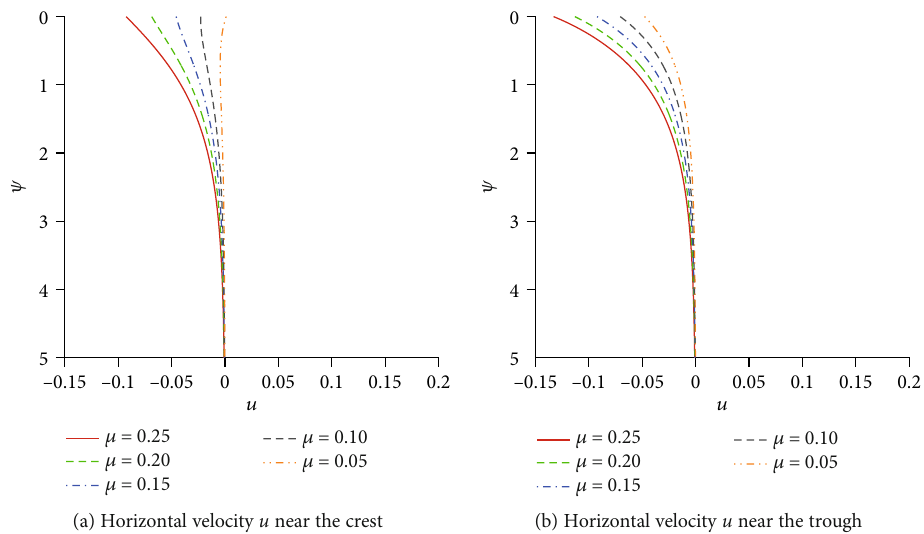
Figure 9: The in fl uence of the opposing shear currents on the horizontal velocity pro fi le u of propagating periodic waves for di ff erent vorticity parameter μ by means of c = − 0 : 4 . Solid line: μ = 0 : 25 ; dashed line: μ = 0 : 20 ; dash dot line: μ = 0 : 15 ; long dash line: μ = 0 : 10 ; dash dot dot: 0 μ = 0 : 05